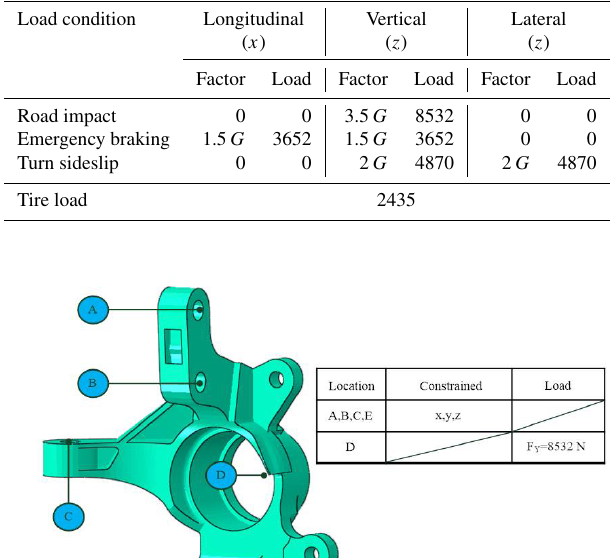
Table 1. Vehicle load factor and specific load conditions (Fan et al., 2011). Unit: Newton.